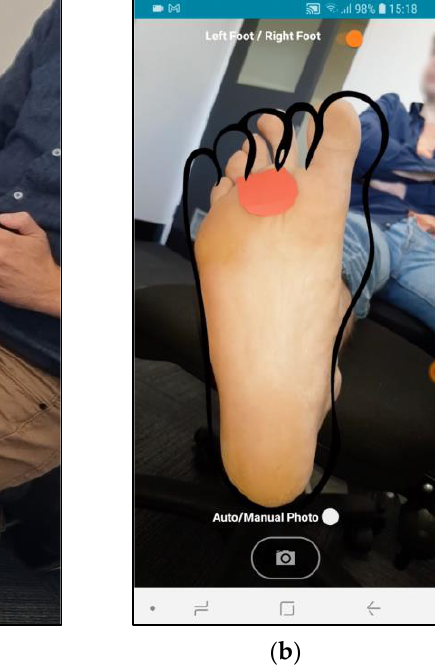
Figure 2. ( a ) Taking photos for a foot check requires the person with the DFU to rest their foot on a chair while another person takes a photo. ( b ) A silhouette supports photographers in taking photos at a consistent distance.